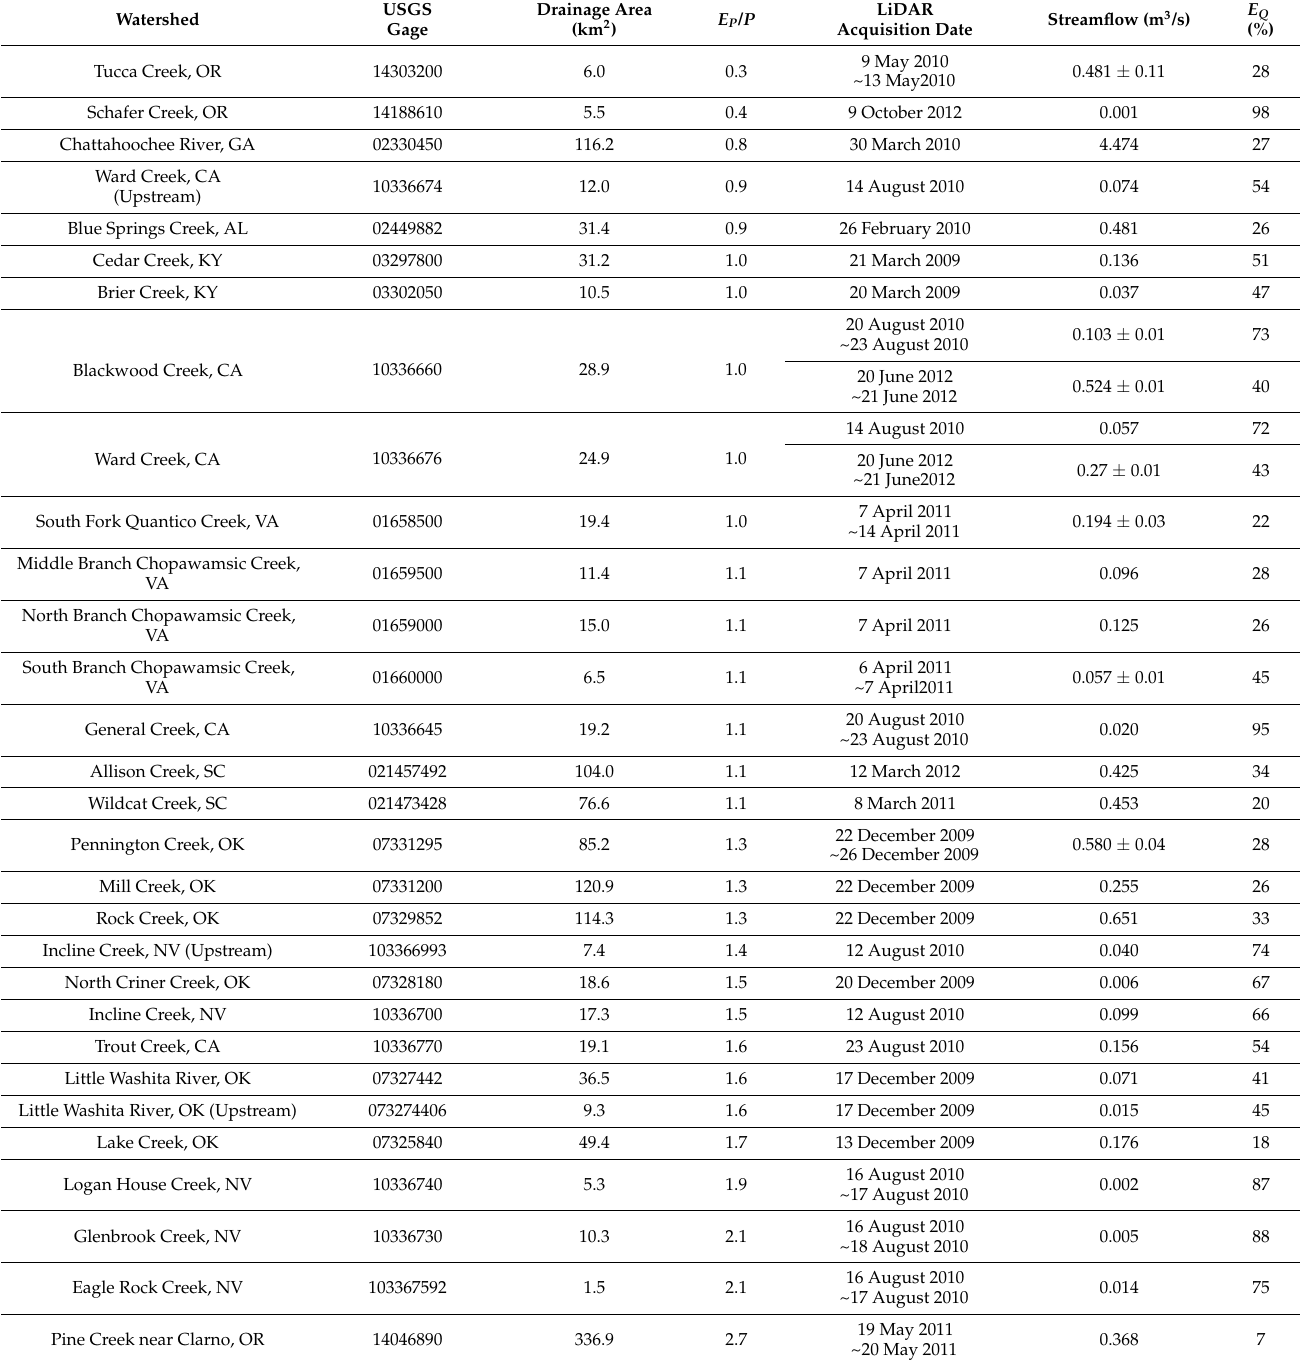
Table 1. United States Geological Survey (USGS) gage identification number, drainage area, climate aridity index, streamflow during the lidar survey, and its exceedance probability during the LiDAR surveys for the study watersheds. [ E p / P : climate aridity index as the ratio of annual potential evaporation ( E p ) to precipitation ( P ), E Q : exceedance probability of streamflow].